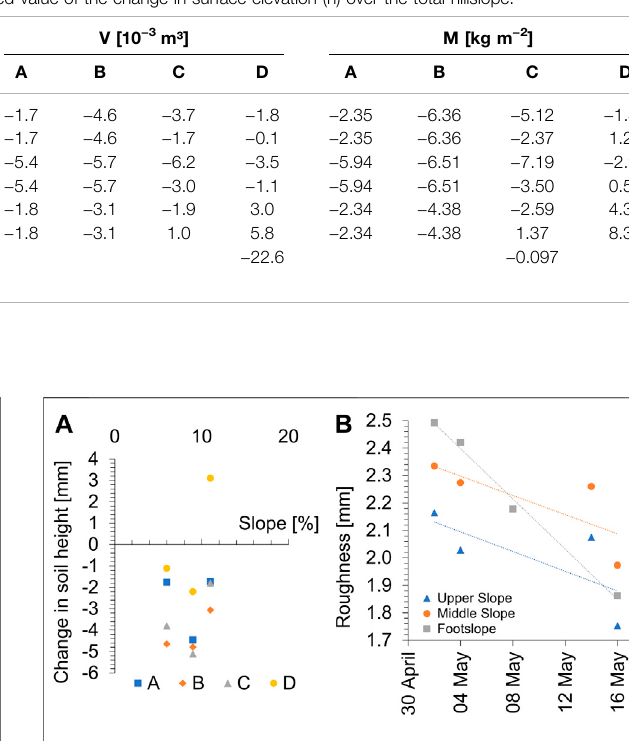
FIGURE 7 | (A) Corrected changes in soil elevation assuming a thickness of the tilled soil, (cid:2) z t 1 ts , of 5 cm since May 2 dependent on the slope at different times: A – May 4; B – May 14; C – May 16; D – temporal change in soil elevationbetweenMay14andMay16; (B) Soilroughnesschangeatthe upper-, middle- and footslope between May 2 and May 16 (The DEM of the footslope was created at May 8 instead of May 14 since the image quality of thepicturestakenonMay14didnotprooftobesuf fi